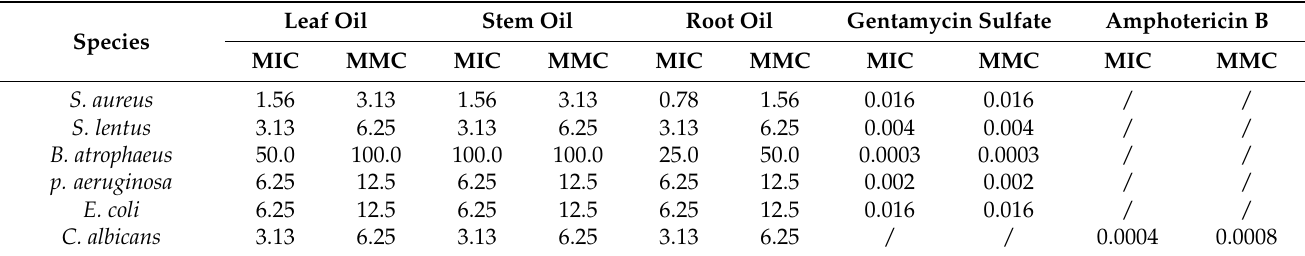
aeruginosa (P. aeruginosa) , Escherichia coli (E. coli) , and Candida albicans (C. albicans) ranged